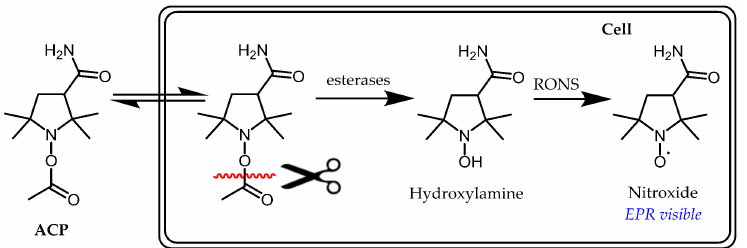
Figure 6. Principle of acyl-protected hydroxylamine spin probes. As with free hydroxylamine, RONS detection is based on an electron-transfer